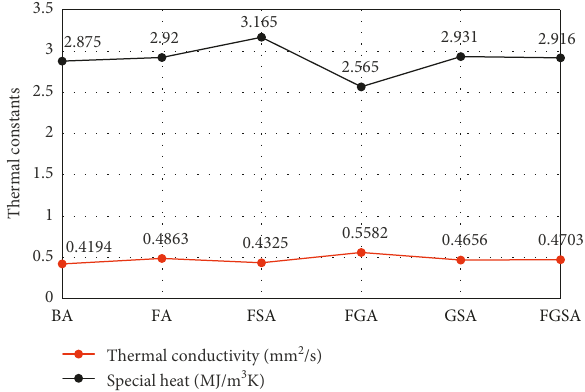
Figure 8: Thermal constants of different asphalt